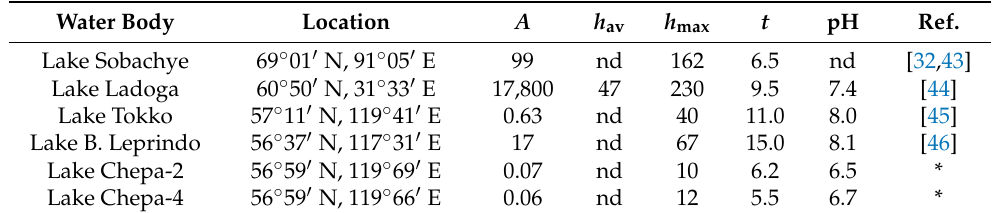
Table 1. Description of studied water bodies: locations of sample sites; surface area ( A , km 2 ); average depth ( h av , m); maximum depth ( h max , m); water temperature at 0–5 m ( t , °C) in periods of sampling (summer–autumn); pH; and references (Ref.).